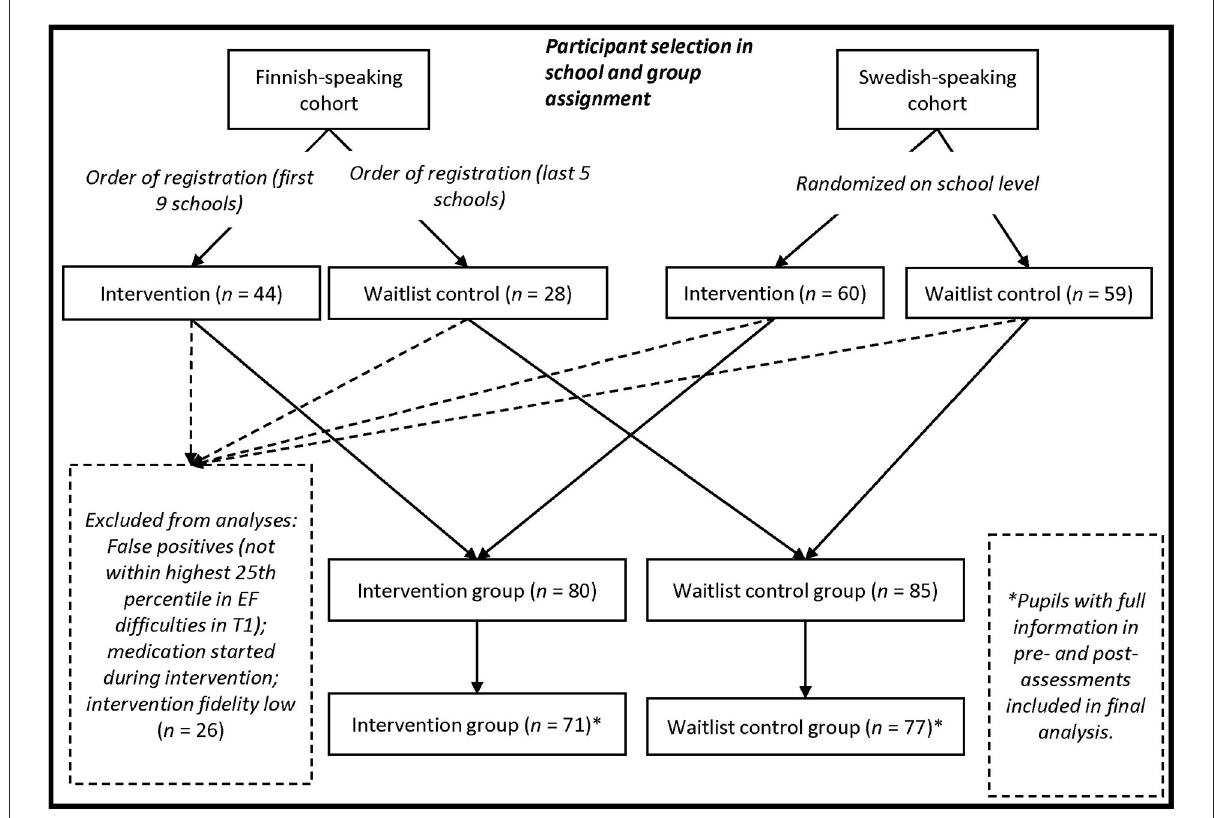
FIGURE1 Flow chart for participant